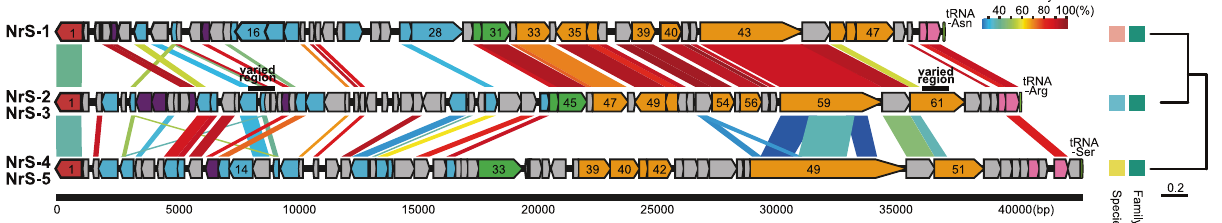
Fig. 3 Genome organization and whole-genome comparison of Nitratiruptor temperate phages (left) and their genome-based phylogenetic tree (right). Arrows represent predicted genes and coding directions. Colors show different functional groups of gene products: red, integration; light blue, genetic switch, replication and recombination; green, packaging; orange, structural protein; pink, cell lysis; purple, other function; and gray, unknown. Gene homology between temperate phages was visualized by the degree of sequence identity between a pair of NrS-2 and NrS-3 shared 100% identical sequences except for two varied regions (black bar). The genomes of NrS-4 and NrS-5 were 100% identical to each other. The phylogenetic tree was constructed by VICTOR using the complete genome sequences of these temperate phages. Colors indicate the classi fi cation at the species and family